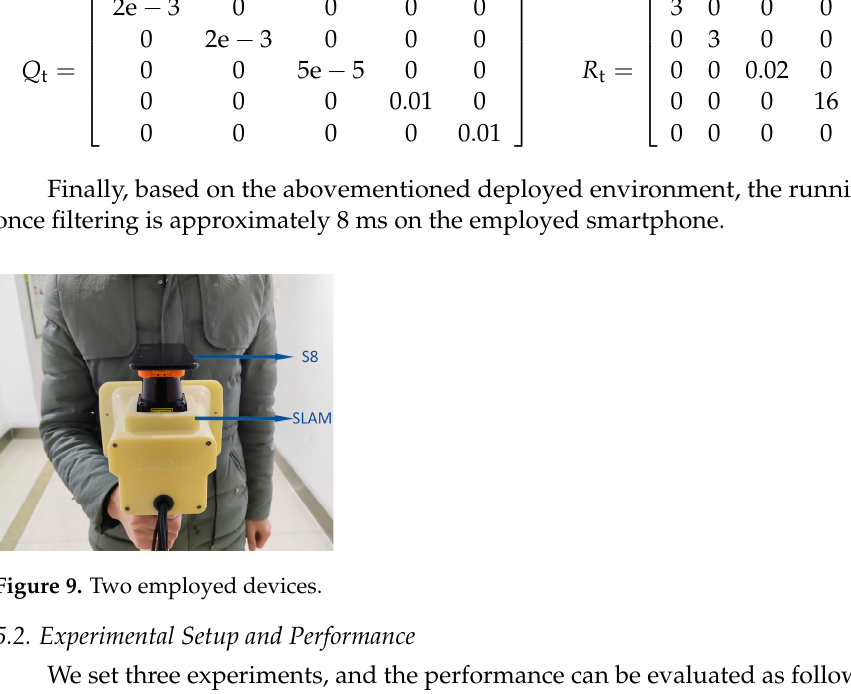
Figure 10. CDF for the handheld SLAM device